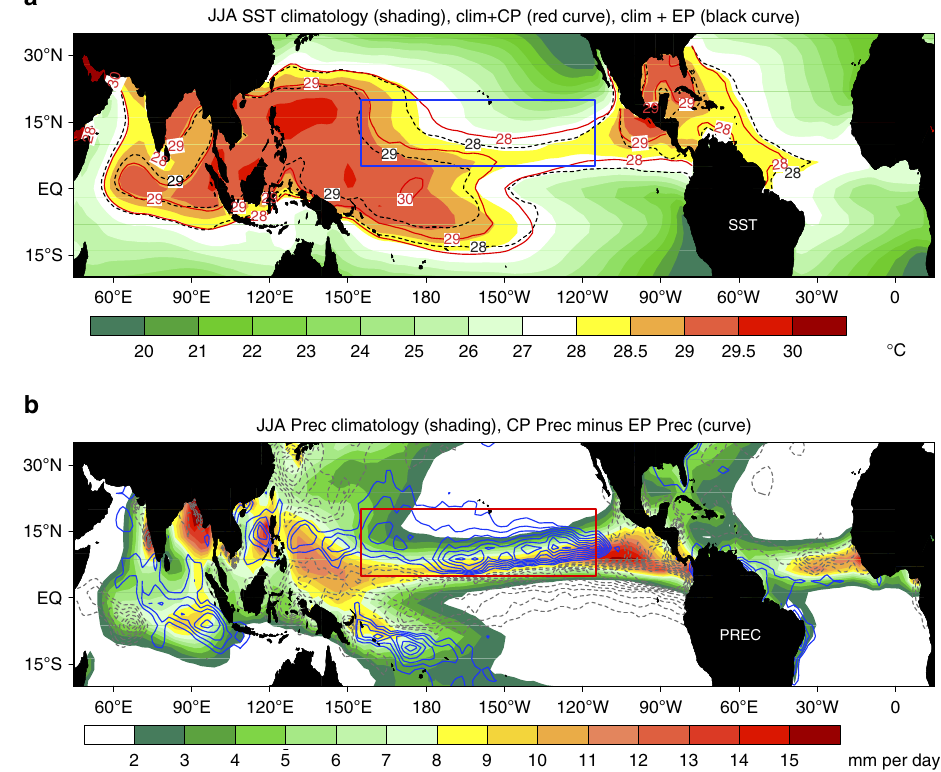
Figure 3 | Regime differences between CP El Nin˜o and EP El Nin˜o. ( a ) Composite patterns of total SST for CP El Nin˜o (red solid lines) and EP El Nin˜o (black dashed lines). Total SST is defined as the sum of SST anomalies shown in Fig. 1 plus the SST climatology in the boreal summer (only the total SST above 28 (cid:2) C is shown, with an interval of 1 (cid:2) C). ( b ) Composite marine precipitation differences (‘CP minus EP’, 0.4mm per day interval) between CP El Nin˜o and EP El Nin˜o. Shadings in a , b show the climatology of SST and precipitation, respectively. Blues/red boxes outline the key forcing